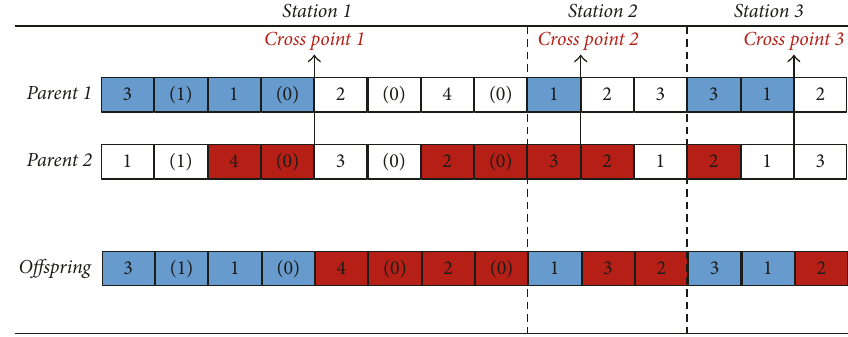
Figure 11: The example of crossover operator.